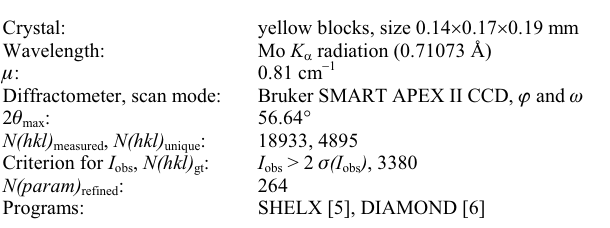
Table 1. Data collection and handling.